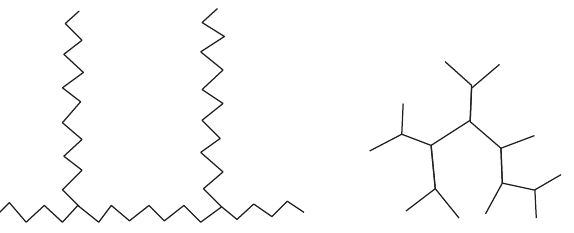
Figure 1: Schematic representation of a chain reaction with the rare chain branching (as hydrocarbon oxidation) and completely branched reaction (as nuclear reactions) [14].